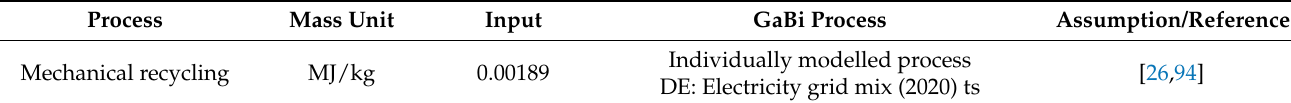
Table 2. Inventory mechanical